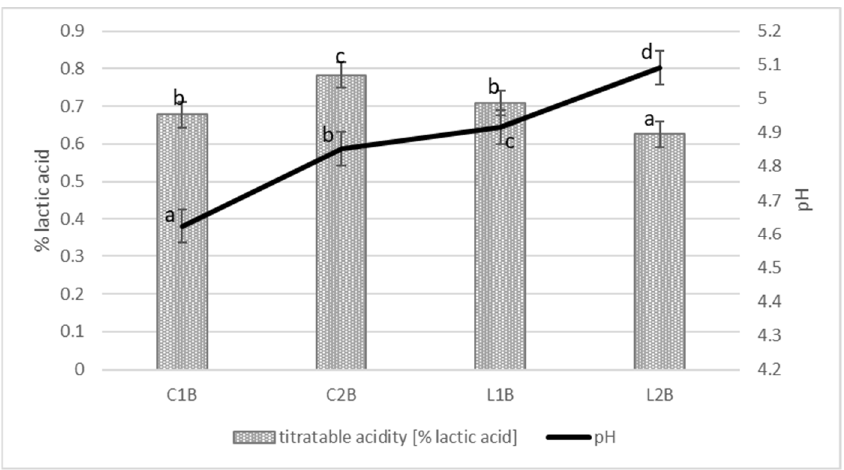
Figure 1. Titratable acidity and pH of tested buttermilk. C1B—commercial buttermilk 1; C2B—commercial buttermilk 2; L1B—laboratory buttermilk with MO 242 culture; L2B—laboratory buttermilk with MSO culture. Different letters indicate statistically significant differences ( p < 0.05) between mean values.